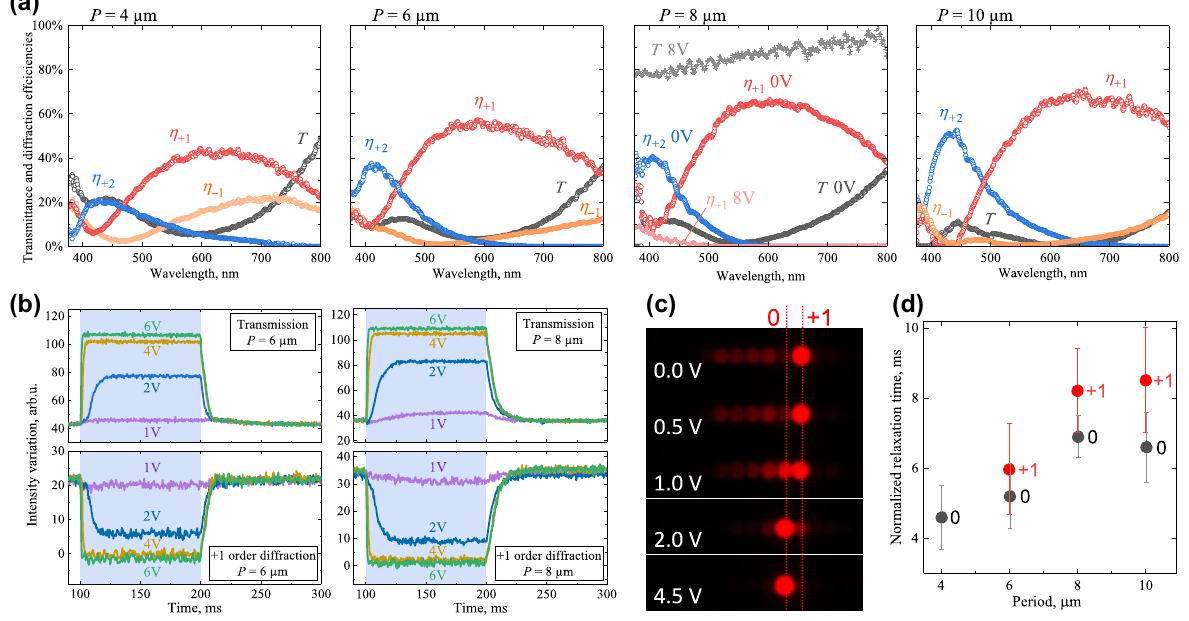
Figure 5: Diffraction properties of double-sided LC-metasurfaces and their electro-optical switching. (a) Spectra of transmittance and efficiencies of strongest diffraction orders of the metasurfaces of periods indicated on the top. Comparison with the spectra upon alternating voltage of a 8 V amplitude is shown for the 8 μ m periodic metasurface. (b) Dynamics of variation of the intensity of light transmitted and diffracted into + 1 order by the 6 μ m and 8 μ m periodic metasurfaces driven by voltages of the indicated amplitudes. Time intervals when the voltage is applied are shown by the light-blue background. (c) Variation of the optical BFP-images in red light of the 8 μ m periodic metasurface upon applying the voltage of indicated amplitudes with the positions of the spots corresponding to 0 and + 1 diffraction orders connected with dotted lines to guide the eye. (d) Combined times of normalized relaxation of 0 and + 1 diffraction orders of all metasurfaces after the voltage is switched off. The diffraction orders are indicated directly at the dots, while the error bars show the ranges of relaxation time exhibited by metasurfaces switched by different